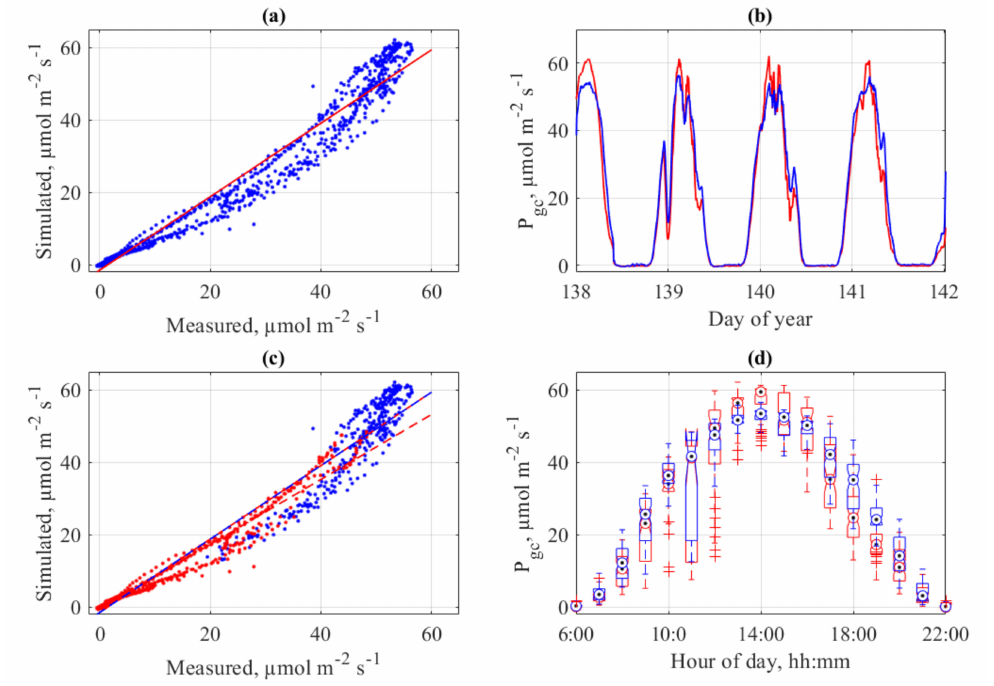
Figure 13. Measured and Simulated crop gross photosynthesis (P gc ) of tomato cv ‘Pannovy’ for four selected days in Experiment 3 with a)simulated vs. measured values ( a ; R 2 0.967), time course of measured (red) and simulated (blue) ( b ), simulated vs. measured values before 12 h (red) and after 12 h (blue) ( c ), and crop gross photosynthesis (P gc ) as function of hour per day for measured (red) and simulated (blue) ( d